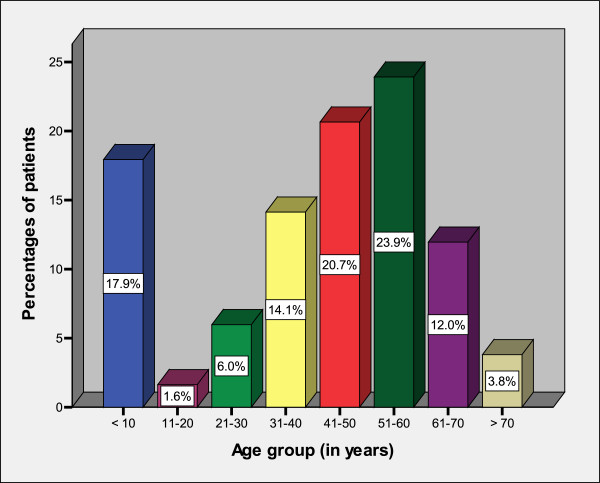
Distribution of patients according to age group.